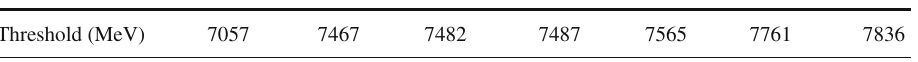
Table 10 D ij coefficients for sector J P = 1 / 2 − (MA)